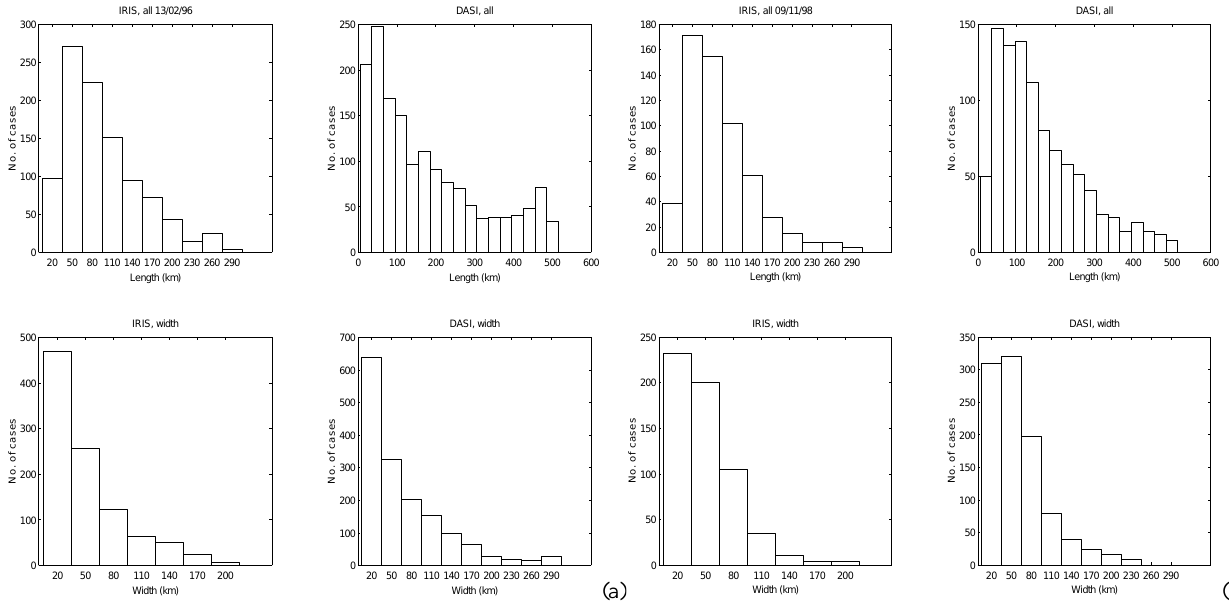
Fig. 7. Histograms of the lengths and widths of all separated closed contours during the two observing periods, (a) 13–14 February 1996 (17:00–01:00UT) and (b) 9 November 1998 (17:00–22:00UT). In each figure, the IRIS results are shown on the left-hand side, and the DASI results on the right-hand side.